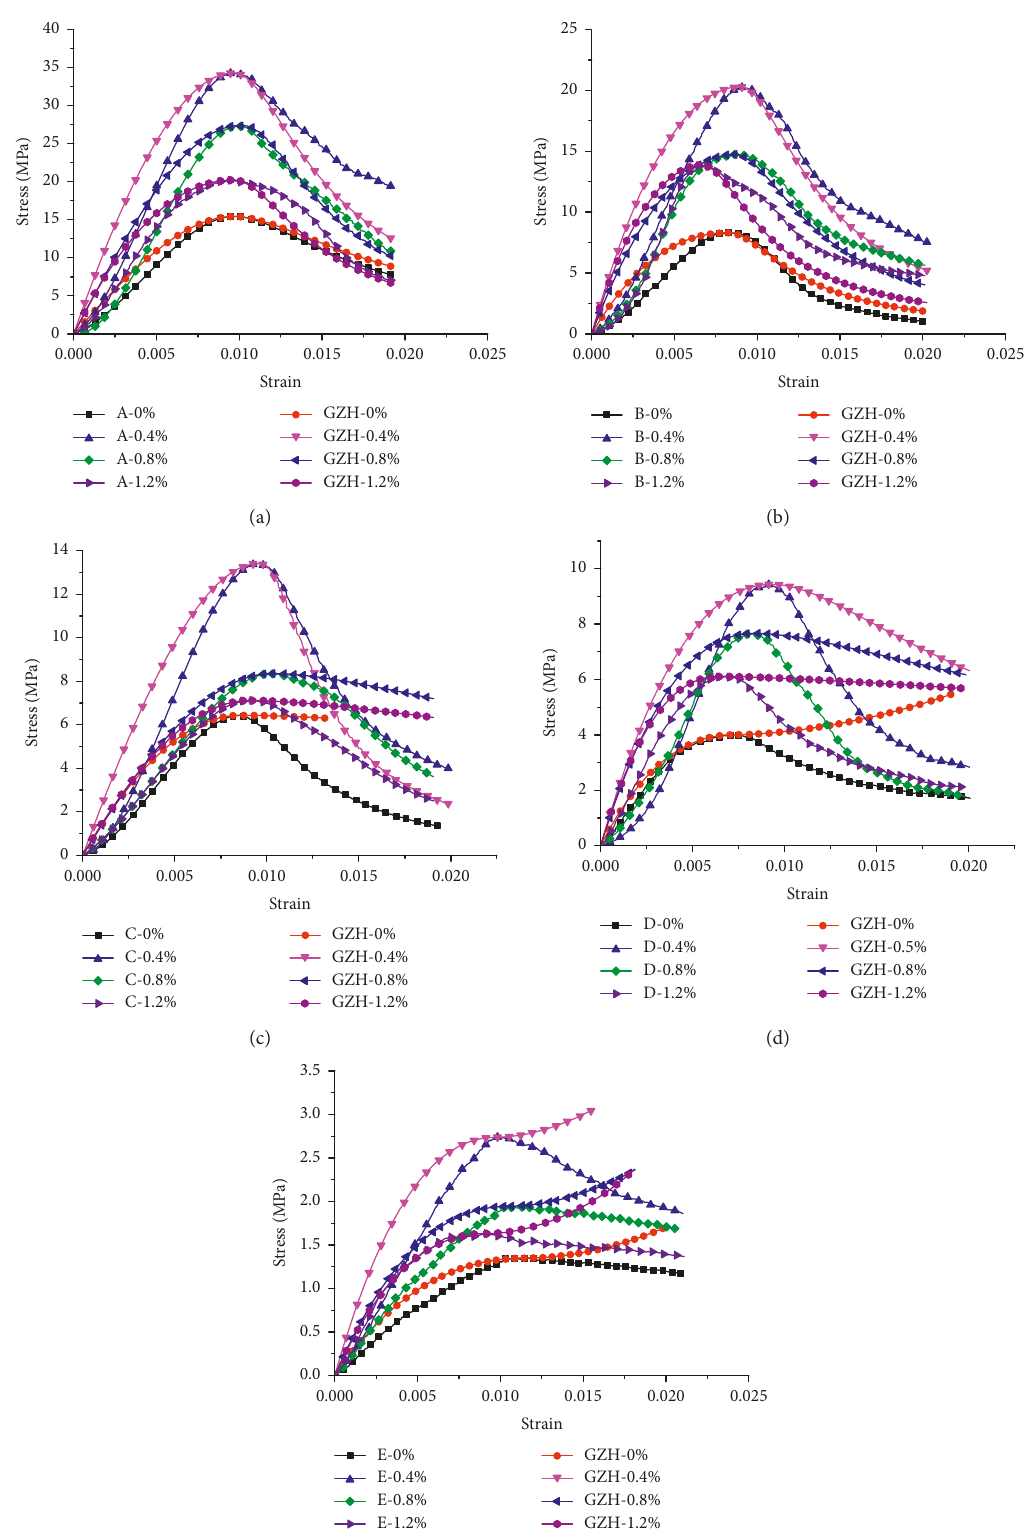
Figure 4: Fitting results of the curve of BF-CRM based on the GZH model: (a) A group; (b) B group; (c) C group; (d) D group; (e) E